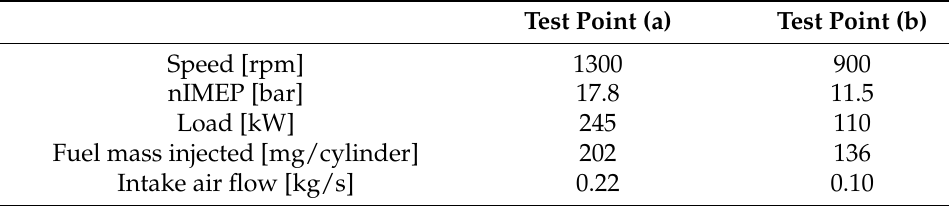
Table 2. Engine operating